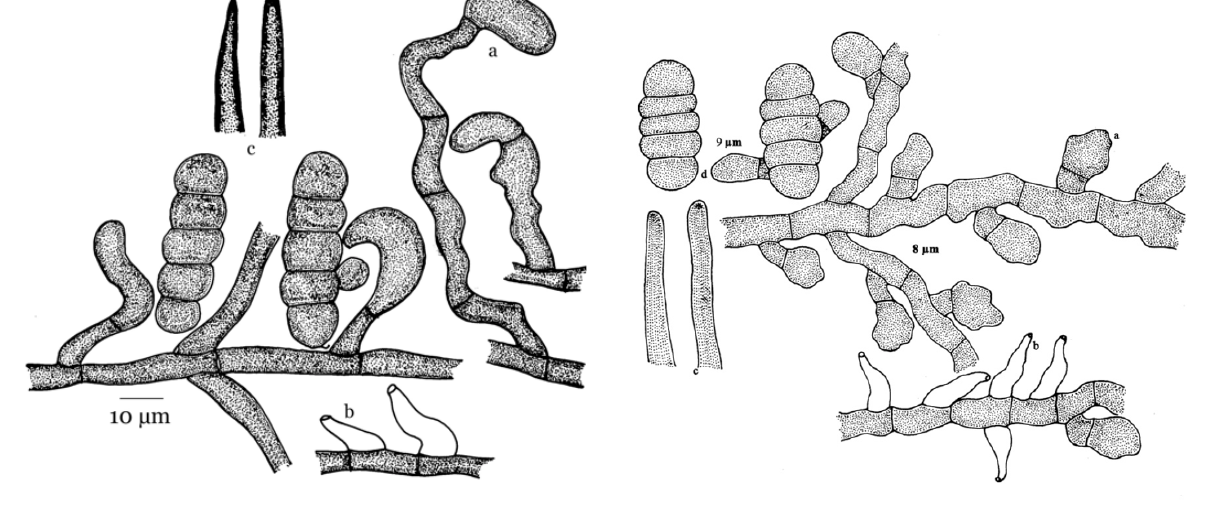
Figure 109. Meliola premnigena a - Appressorium; b - Phialide; c - Apical portion of mycelial setae; d - Ascospore s